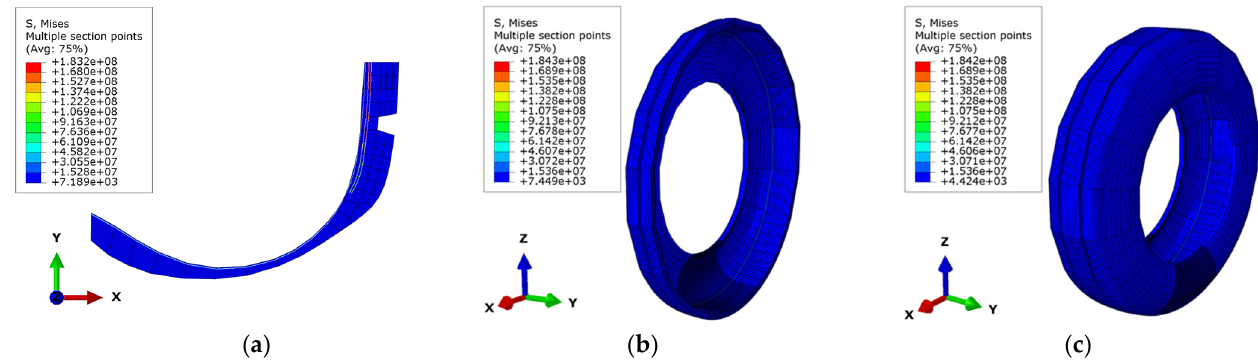
Figure 1. Tire modeling. ( a ) Axisymmetric model; ( b ) partial 3D model; ( c ) full 3D